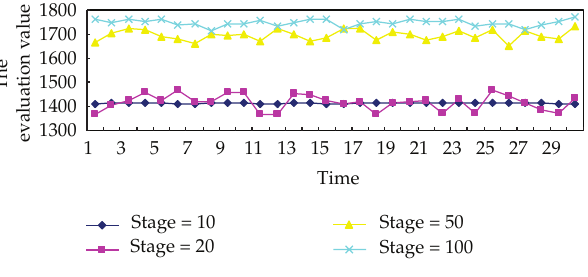
Figure 4: Computational